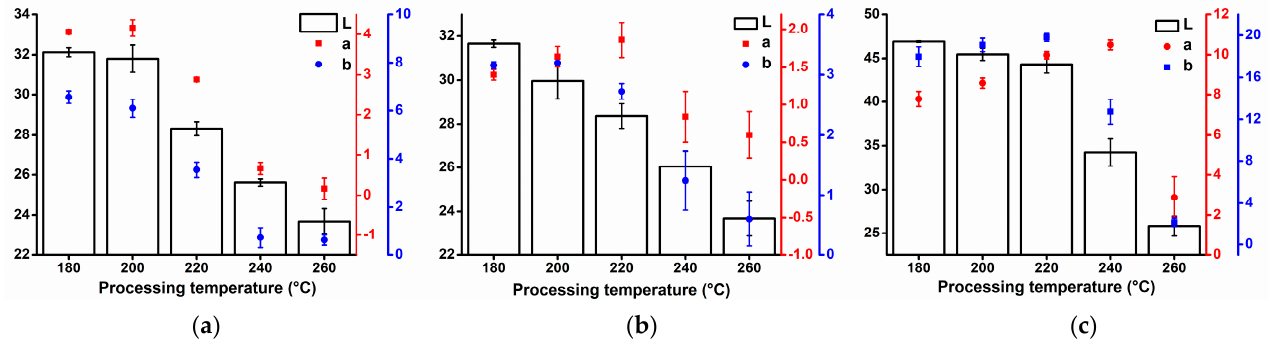
Figure 4. Colorimetry results ( L*a*b* ) of the composites processed at different temperatures: ( a ) PP/hemp; ( b ) PP/flax; ( c ) PP/Lyocell.